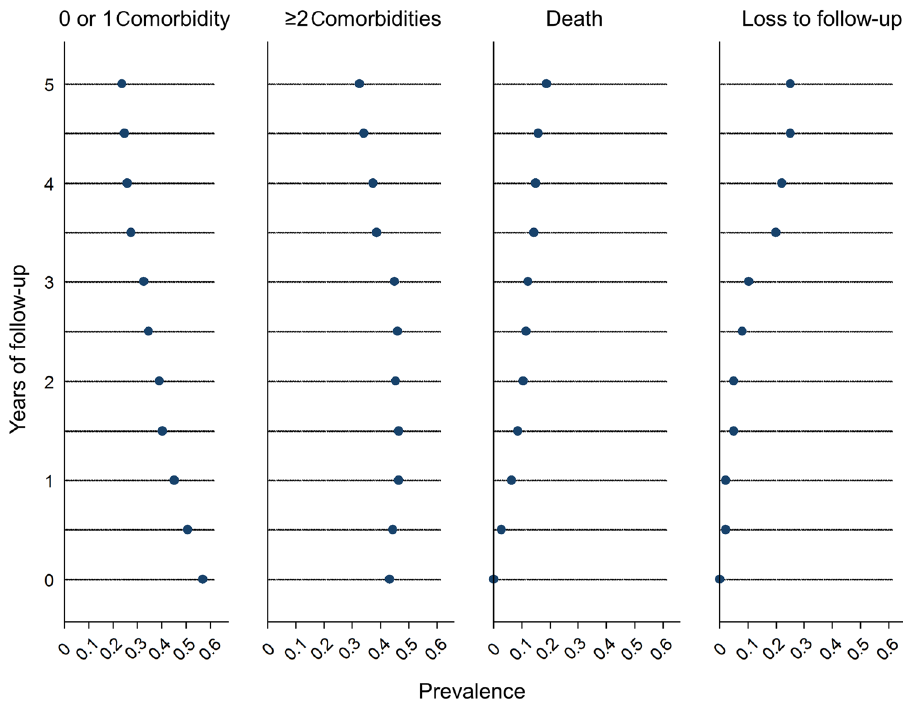
Fig. 1 Distribution of patients with 0 or 1 category of comorbidities, ≥ 2 categories of comorbidities, and patients who were dead or lost to follow-up over time ( n = 409). Seven categories of comorbidities were included. At each visit, we recorded if the patients had been diagnosed with cardiovascular diseases, neurological disorders, endocrine disorders, musculoskeletal disorders, and cancers and we also recorded if the patients had ever reported having infections and mental disorders (anxiety or depression) after being enrolled in the study. Over time, patients in the groups “ 0 or 1 comorbidity ” or “ ≥ 2 comorbidities ” can move to the group “ death ” or “ loss to follow-up ” . Also, patients in the group “ 0 or 1 comorbidity ” can move to the group “ ≥ 2 comorbidities